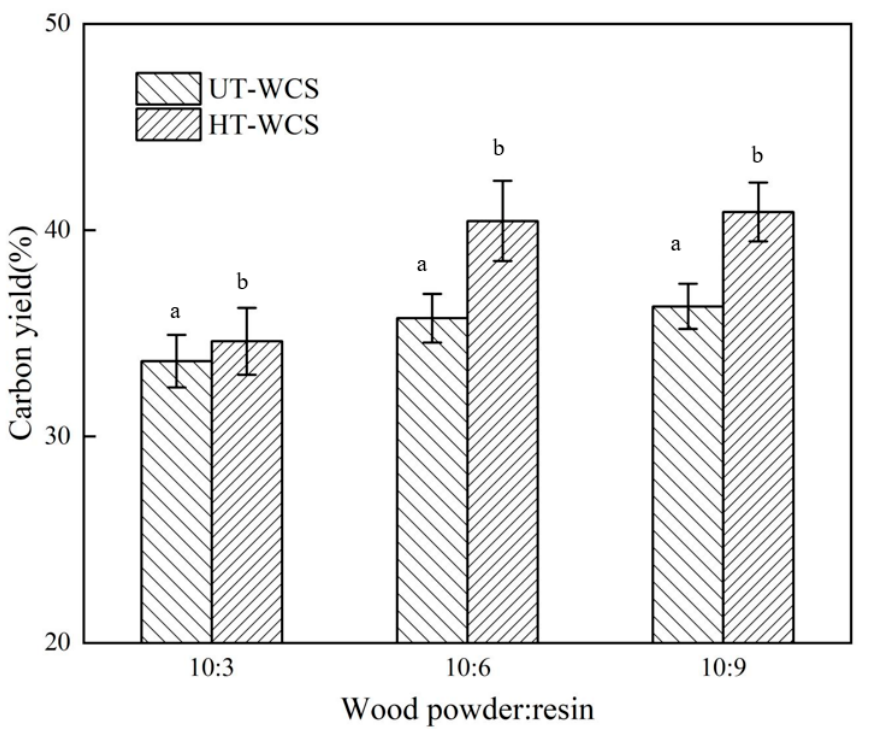
Figure 3. ( a ) The carbon yield of UT-WCS; ( b ) The carbon yield of HT-WCS. Different letter (a,b) indicate significant difference between carbon yield (%) at 99% confidence level. Forests 2020 , 11 , x FOR PEER REVIEW